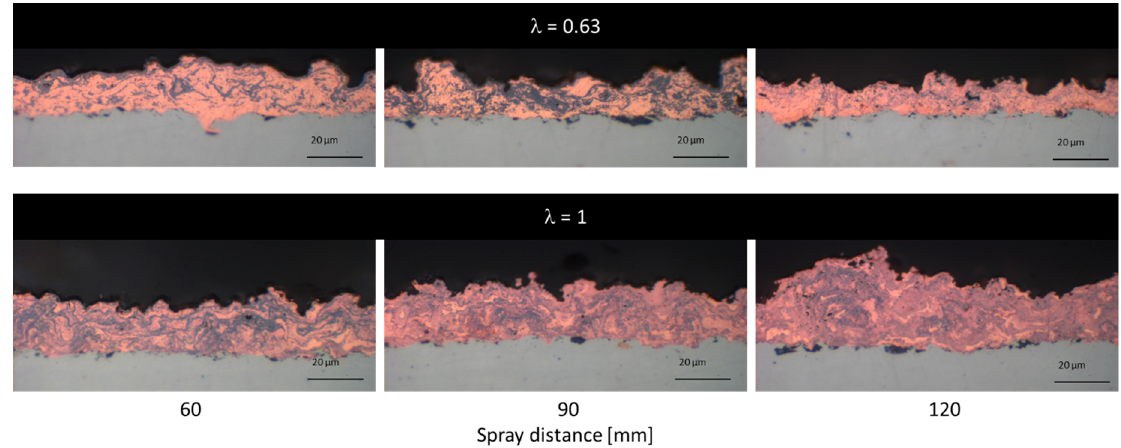
Figure 10. Optical microscope cross-section images of the Cu coatings sprayed with two different λ (0.63 and 1) and with three different spray distances (60, 90, and 120 mm). Taken from [21].